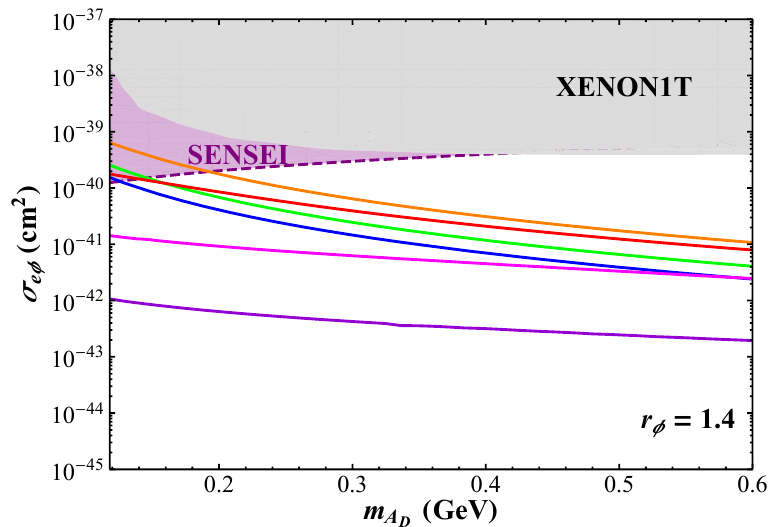
4 , Figure 11. The direct detection cross sections σ eφ (given in eq. (5.1), assuming b = 1 , (cid:15) = 3 × 10 − and r φ = 1 . 4 , for various selections of r h with g D fixed to recreate the observed dark matter relic abundance. Each contour assumes r h = 1 . 7 (Green), r h = 1 . 9 (Blue), r h = 2 . 1 (Violet), r h = 2 . 2 (Magenta), r h = 2 . 3 (Red), and r h = 2 . 5 (Orange). The XENON1T [33] and projected SENSEI [6] sensitivities are included in the same way as in figure